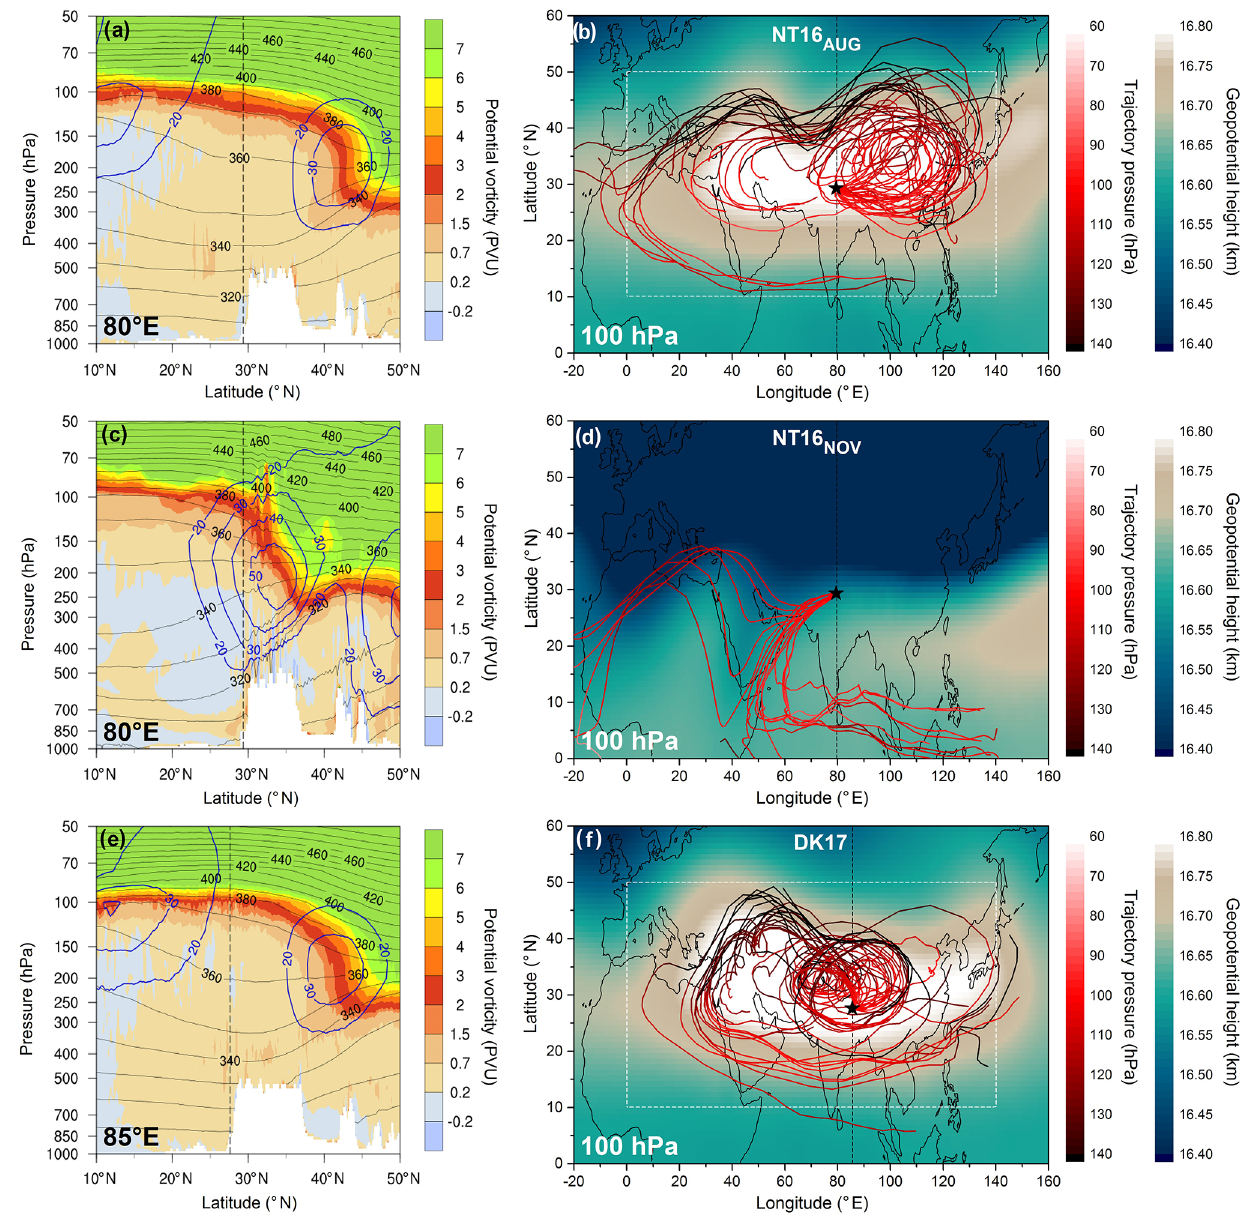
Figure 2. (a, c, e) Latitude–pressure cross sections of potential vorticity (color scale), potential temperature (black contours, in K) and total wind speed (blue contours, inms − 1 ) from the ECMWF analysis data (horizontal resolution O1280 interpolated to a 0 . 125 ◦ × 0 . 125 ◦ grid, vertical resolution L137, 6-hourly) averaged over the NT16 AUG ( a , longitude 80 ◦ E), NT16 NOV ( c , longitude 80 ◦ E) and DK17 ( e , longitude 85 ◦ E) campaign time periods, as given in Table 2. Black dashed lines show the latitude of NT (a, c) and DK (e) . (b, d, f) Geopotential height at 100hPa from ECMWF analysis data averaged over the NT16 AUG (b) , NT16 NOV (d) and DK17 (f) campaign time periods (color scale), and 2-week LAGRANTO backward trajectories calculated along ERA-Interim wind fields (horizontal resolution T255 interpolated to a 1 ◦ × 1 ◦ grid, vertical resolution L60), initialized at 100hPa at the time of each balloon sounding in NT16 AUG (b) , NT16 NOV (d) and DK17 (f) , color-coded by pressure. Black dashed lines show the longitude of NT (a, c) and DK (e) . The white dashed rectangle in (d, f) shows the approximated ASMA area used for the confined fraction calculation (10–50 ◦ N, 0–140 ◦ E; see Sect. 5.2). Note that, for NT16 NOV , trajectories started 6h before and 6h after each sounding are also displayed (d)